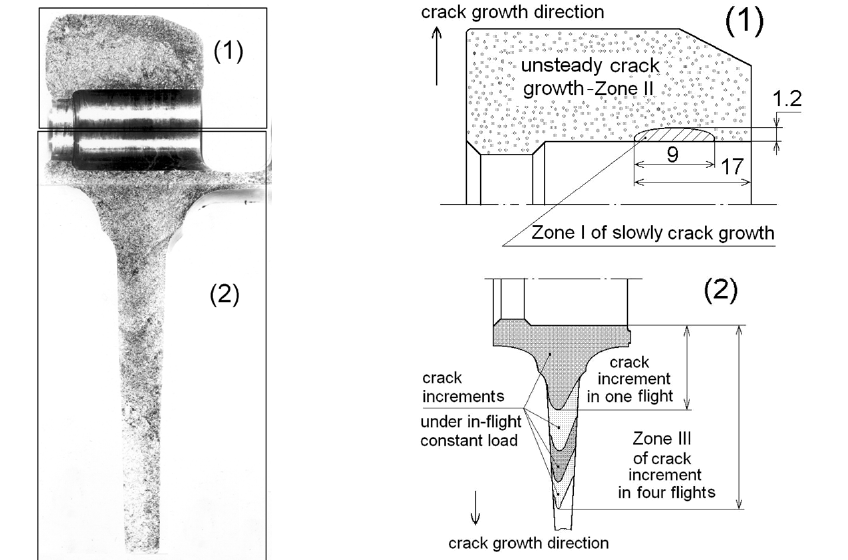
Figure 4: Fracture (general view) in one of the Stage-III turbine discs (NK8-2u engine) has broken in service; (1) and (2) the sequence (schematic) of the crack propagation in a disk.